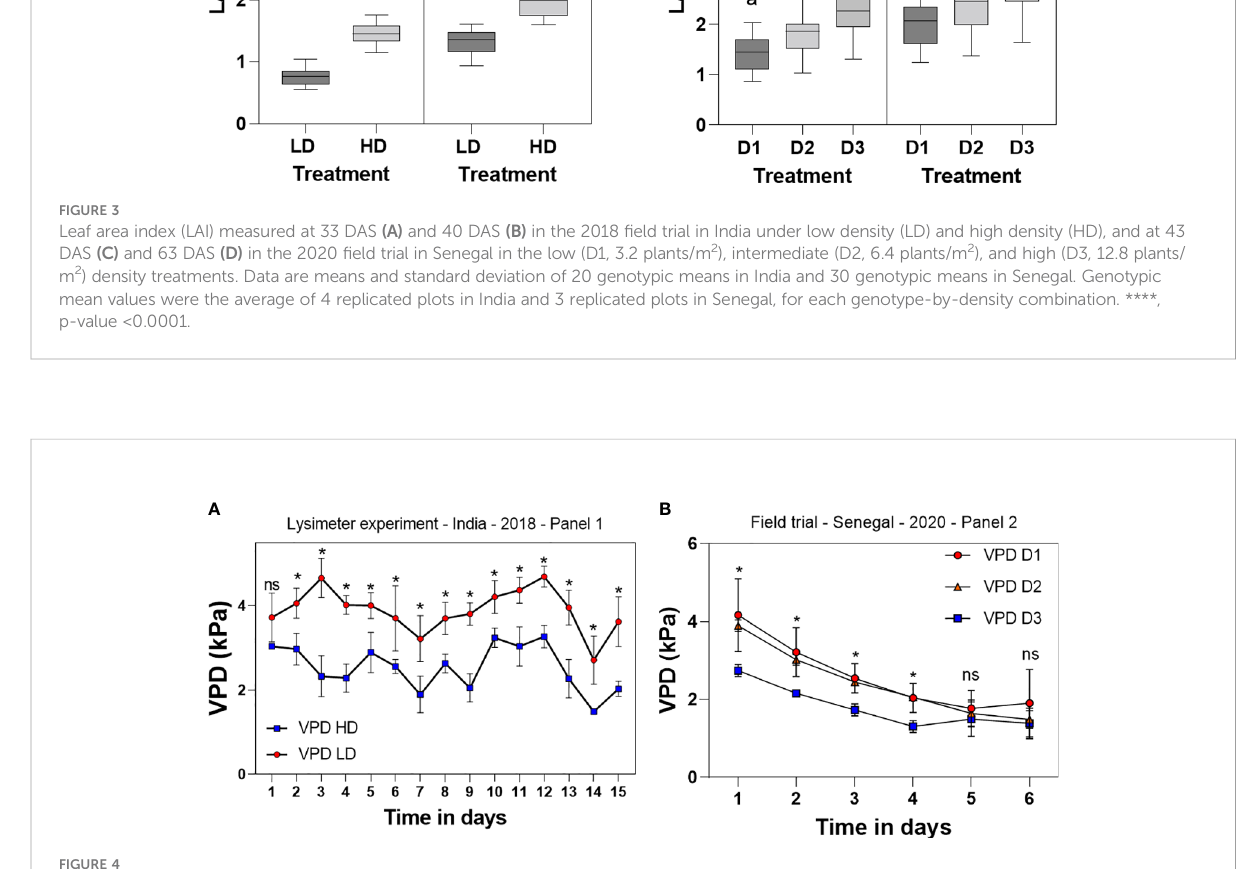
FIGURE 4 Vapor pressure de fi cit (VPD) measured on a 15 days period during vegetative stage in high density (HD) and low density (LD) canopies in the lysimeter trial in India in the germplasm panel 1 during the dry season (A) and in the 2020 fi eld trial in the three different densities (low (D1, 3.2 plants/m 2 ), intermediate (D2, 6.4 plants/m 2 ), and high (D3, 12.8 plants/m 2 )) on a 6 days period before harvest in Senegal (B) in the germplasm panel 2. Each data point is the average of data collected in three plots for each of the densities. ns, non-signi fi cant. *p-value < 0.05.